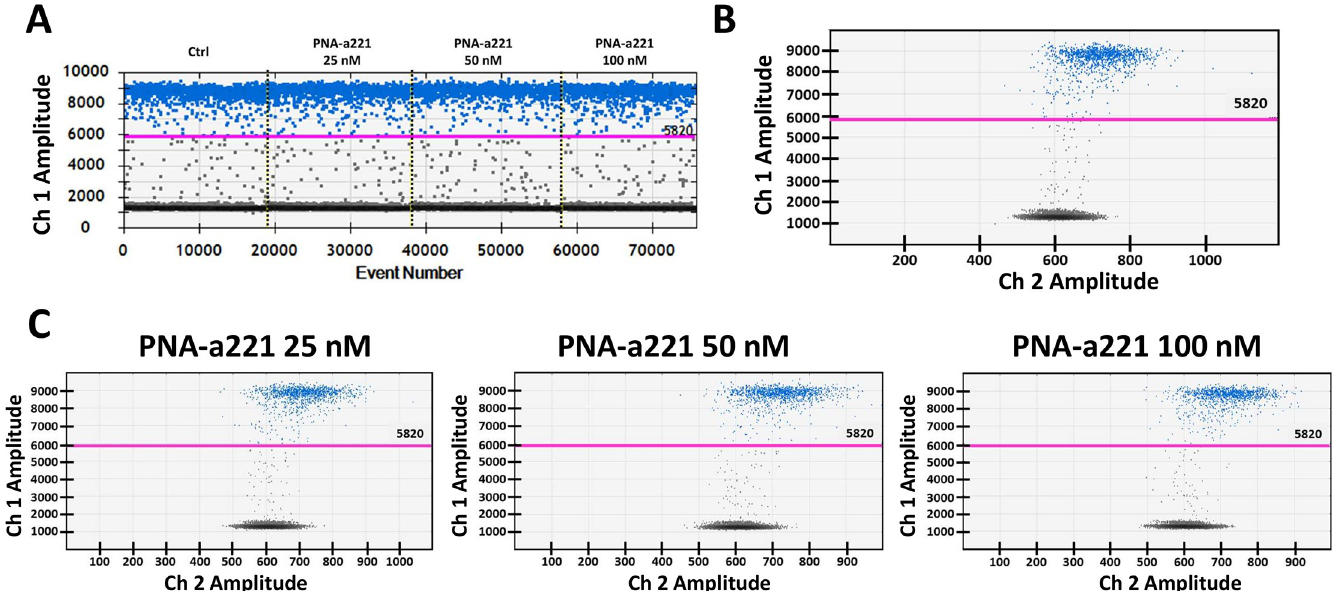
Fig 6. Effects of R8-PNA-a221 on miR-222-3p sequence detection by RT-ddPCR. A. 1D RT-ddPCR plot obtained after the addition of incremental concentration of R8-PNA-a221, miR-222-3p is amplified. B. miR-222-3p content in 1:50 diluted cDNA obtained from U251 cells: 2D plots. C. miR-222-3p content detected after the addition of incremental